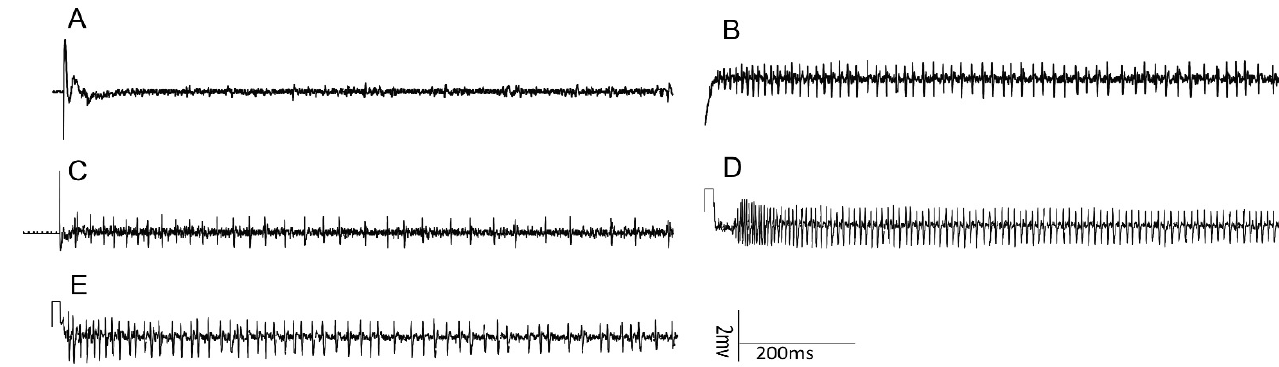
Figure 3. Electrophysiological dose-response curves for strychnine; spike frequencies of the deter- rent neuron in the medial styloconic sensilla of H. armigera and H. assulta caterpillars reared either on standard artificial diet (squares, no strychnine exposure) or artificial diet containing strychnine (diamonds) for the intervals indicated. ( A ) Exposed from neonate until the molt to the 5th instar H. armigera larvae ( n = 10) and H. assulta larvae ( n = 11); ( B ) exposed during 24 h since the molt to the 5th instar; H. armigera larvae ( n = 11) and H. assulta larvae ( n = 9); ( C ) exposed during 36 h since the molt to the 5th instar; H. armigera larvae ( n = 10) and H. assulta larvae ( n = 10); ( D ) exposed during 48 h since the molt to the 5th instar; H. armigera larvae ( n = 10) and H. assulta larvae ( n = 10). ( E ) H. armigera larvae, exposed during 72 h since the molt to the 4th instar; n = 10. Vertical lines represent standard errors. Asterisks indicate a significant difference in response frequency between different groups of diet-experienced caterpillars (two-sample t -test, * p < 0.05; ** p < 0.01).